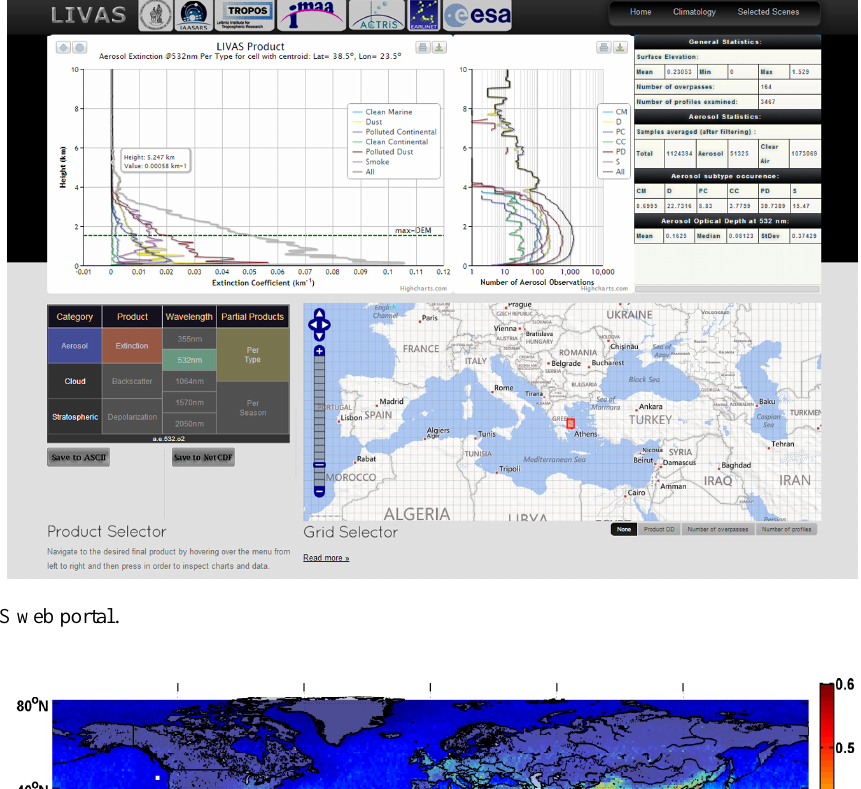
Figure 17. The LIVAS web portal.